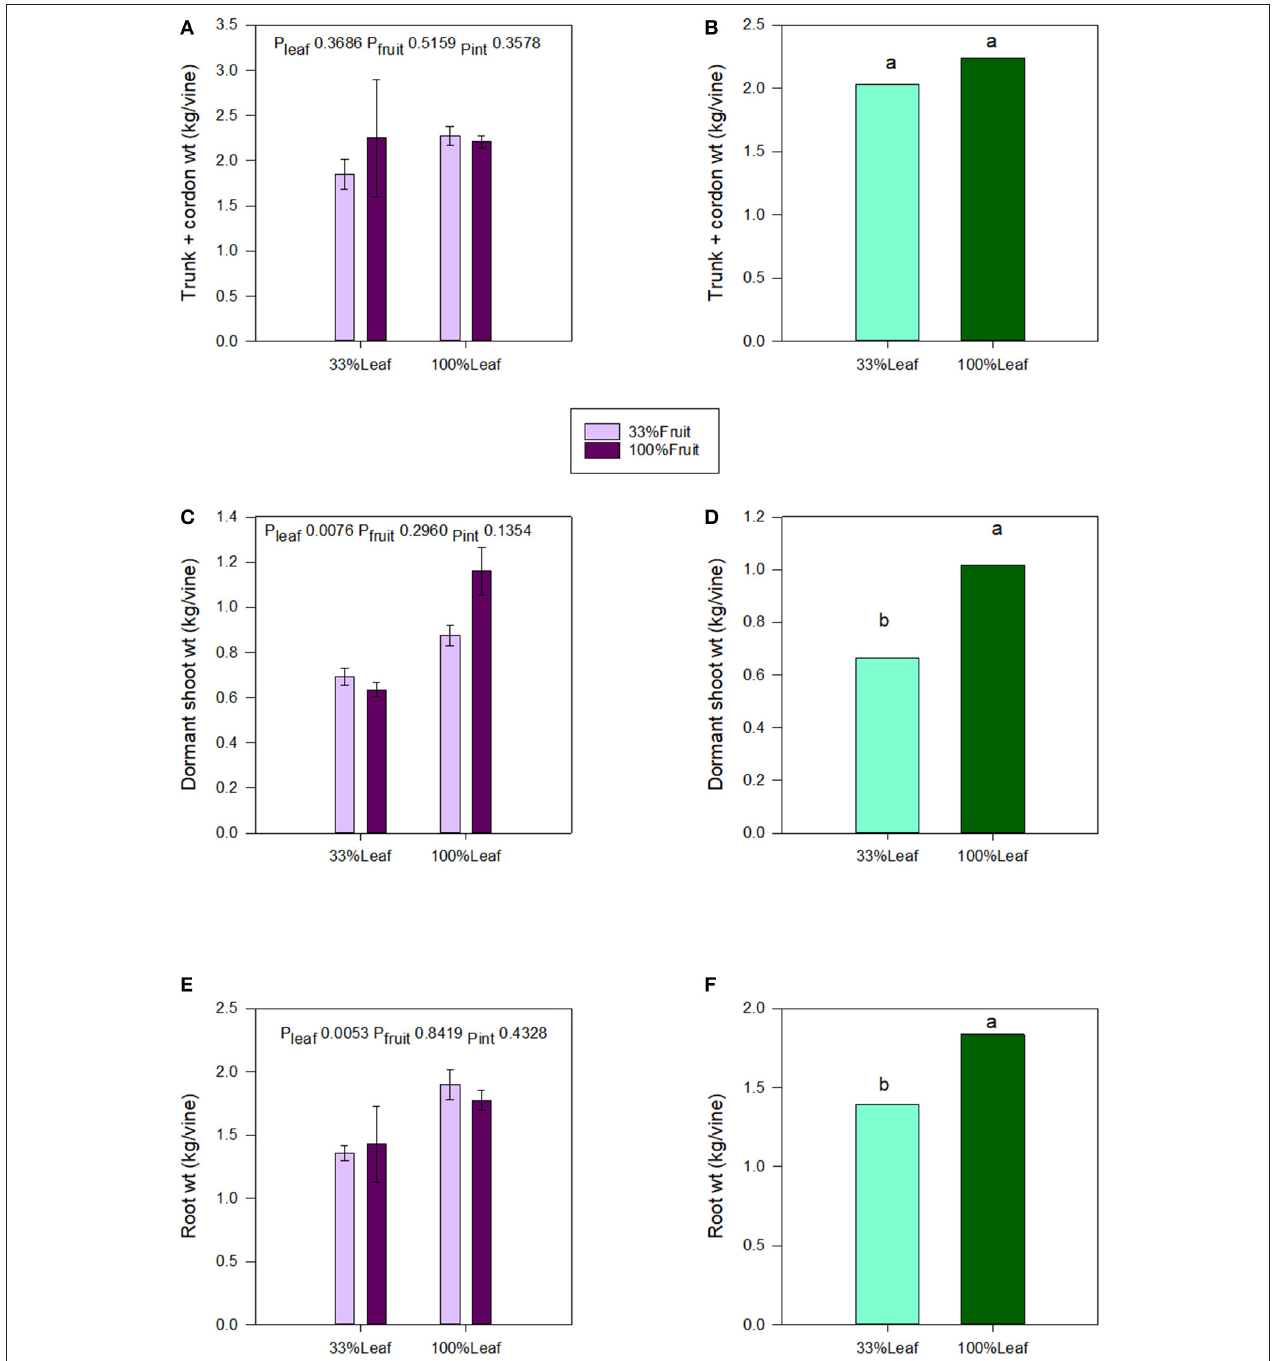
FIGURE 7 | Effect of defoliation and fruit removal on trunk and cordon weight, dormant shoot weight, and root weight of Cabernet Sauvignon grapevine after 2 years of applied treatments. The interactive effects and simple means with standard error of the mean are presented in (A,C,E) . The main effect of defoliation is presented in (B,D,F) . Columns with different letters in main effect panels are significantly different at P < 0.05 according to Tukey’s